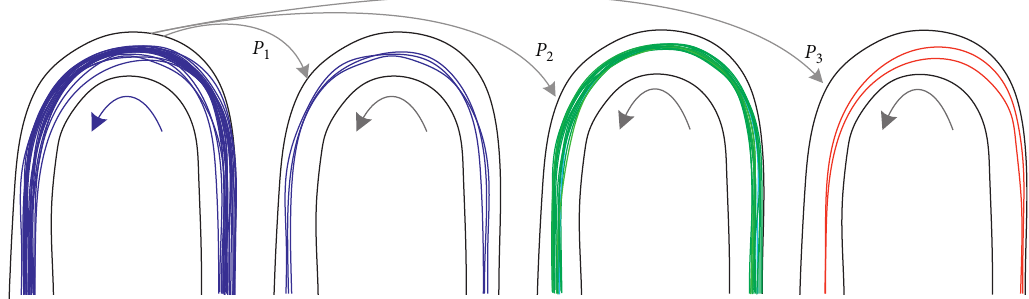
Figure 7: Track morphology and pattern identification at turn